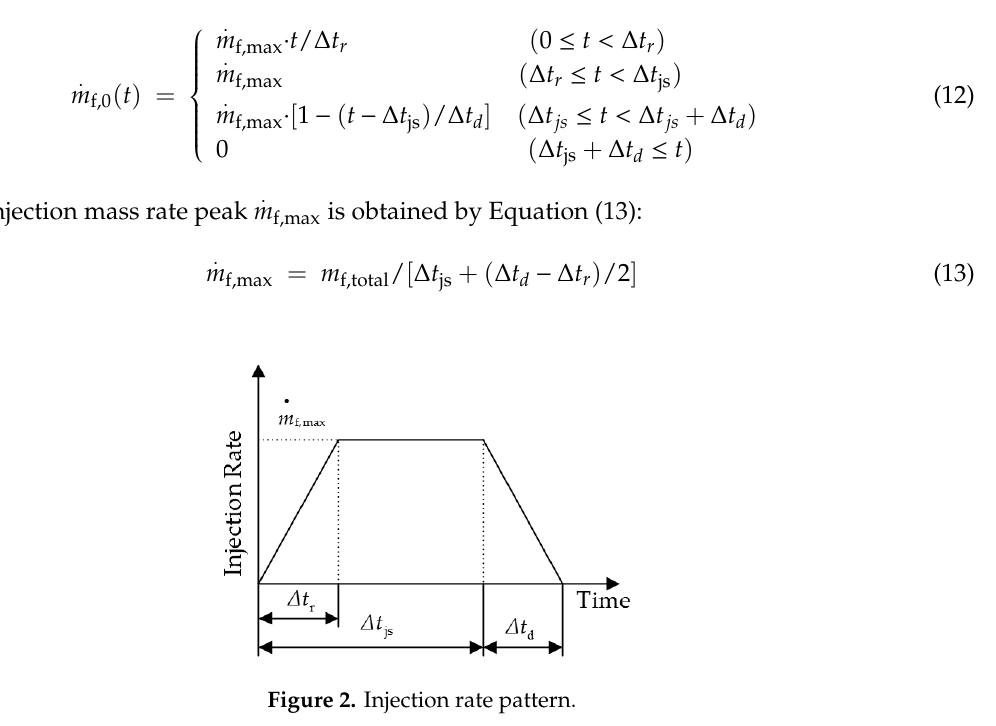
Table 1. Calculation conditions for